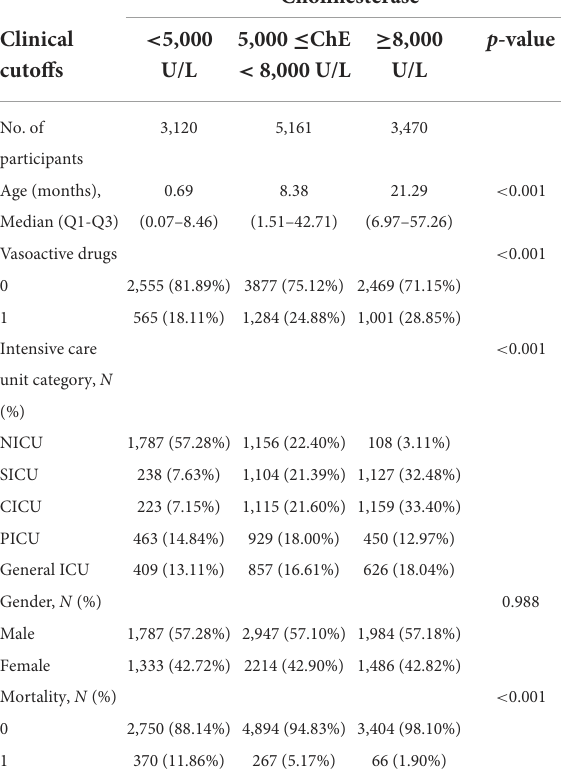
TABLE 1 Baseline characteristics of the study participants. TABLE 2 Characteristics of clinical laboratory results of study